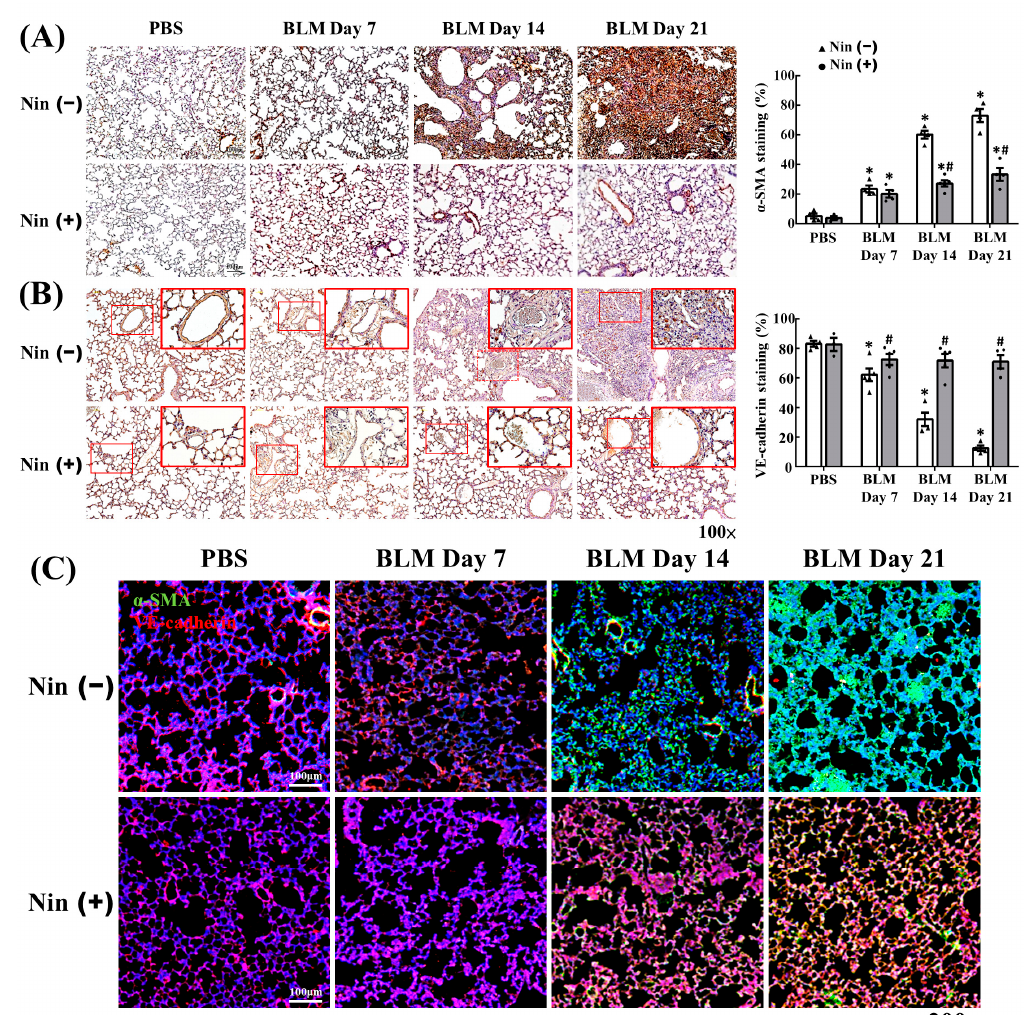
Figure 2. Nintedanib regulates the expression of vascular and mesenchymal markers in murine lungs treated with BLM. ( A ) Representative IHC staining images and the semi-quantification of α -SMA in BLM-treated murine lung sections with or without nintedanib treatment. ( B ) Representative IHC staining images and semi-quantification of VE-cadherin in BLM-treated murine lung sections with or without nintedanib treatment. Insert shows 4-fold magnification of indicated area. Scale bars, 100 µm. n = 3–5 in each group. Data are presented as mean ± standard deviation. * p < 0.05 vs. PBS, and # p < 0.05 vs. BLM (two-tailed Student’s t-test). ( C ) Representative IF staining images of VE-cadherin and α -SMA in BLM-treated murine lung sections with or without nintedanib treatment. Scale bars, 100 µm. Green, α -SMA; red, VE-cadherin; blue, DAPI. α -SMA, alpha smooth muscle actin; BLM, bleomycin; IF, immunofluorescence; IHC, immunohistochemistry; Nin, nintedanib; PBS, phosphate-buffered saline; VE-cadherin, vascular endothelial cadherin.